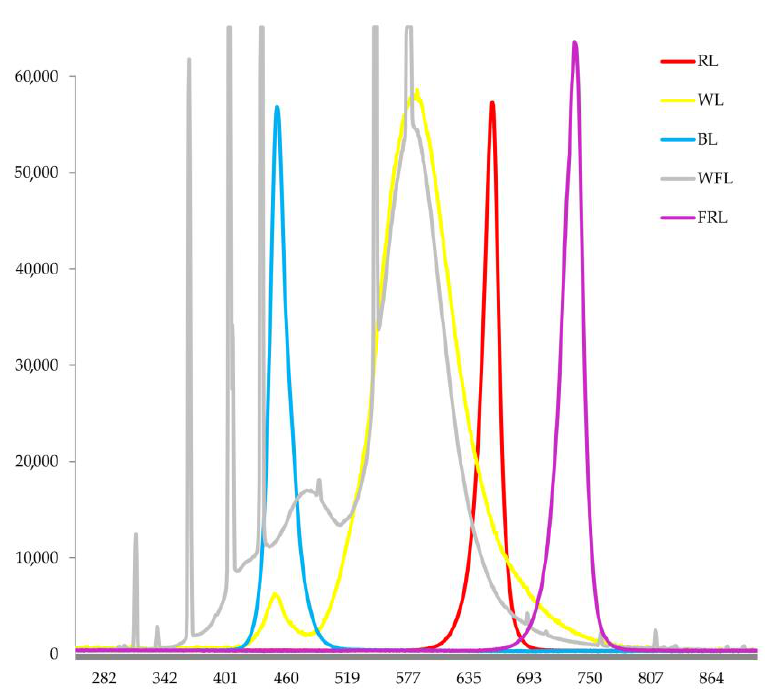
Figure 7. Emission spectra of various light sources used in the experiment.